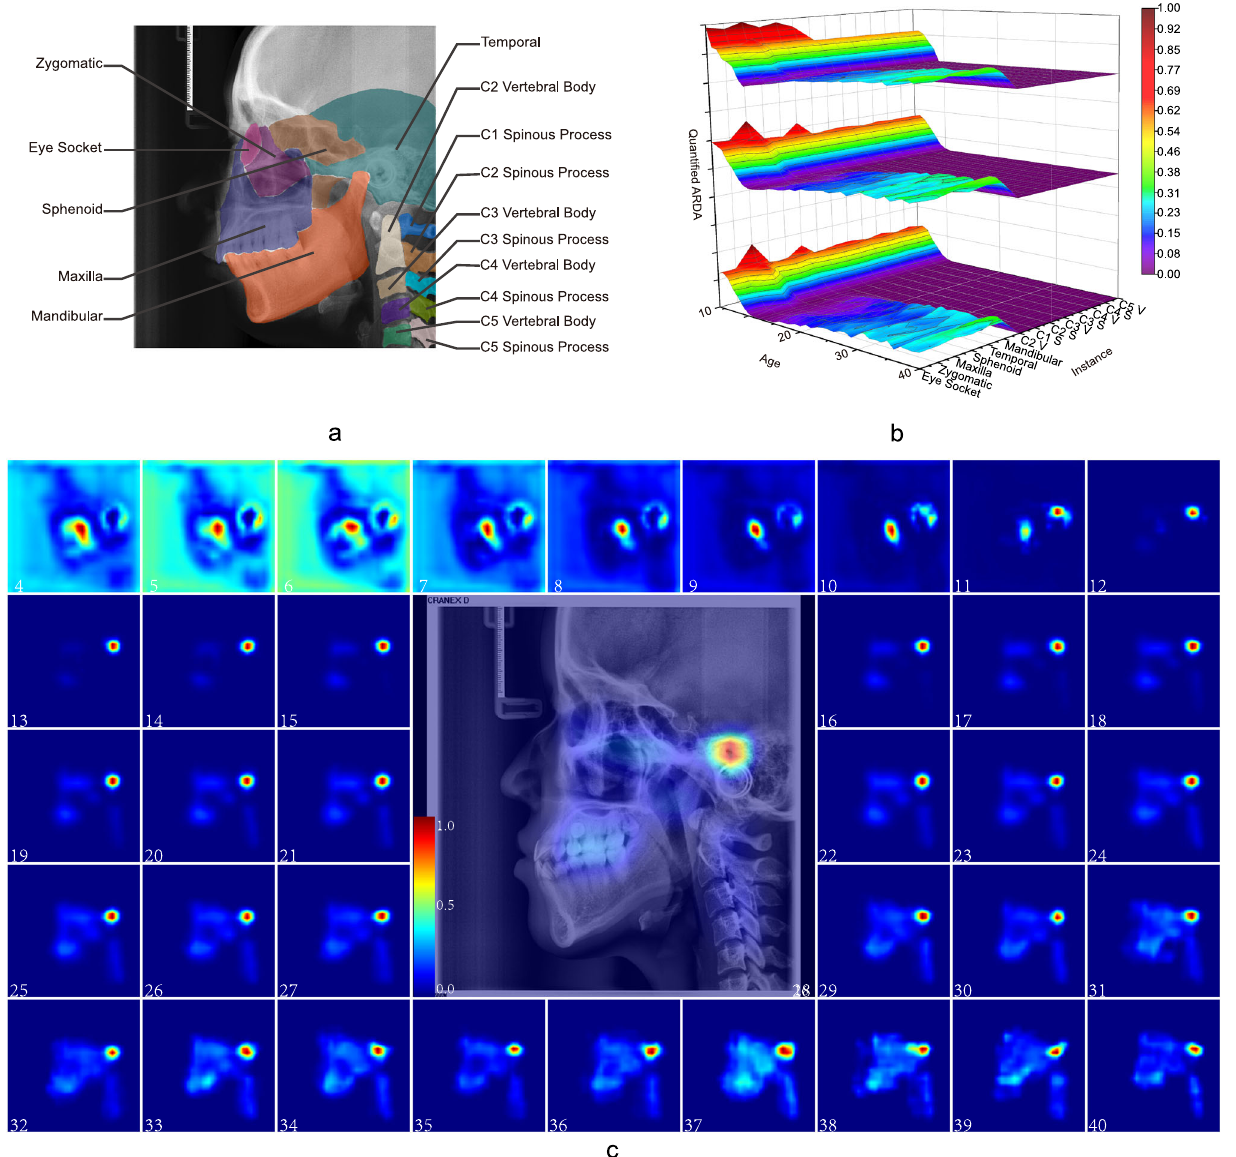
Fig. 1 The ARDA of LCR images. The ARDA is generated from LCR images and a pre-trained deep learning ageing feature extractor. a Instances in LCR images. The parietal and frontal instances are not labeled because the ARDA is barely distributed on them. b Illustration of the quantitative distribution of ARDA on instances in LCR images. The three dimensions are age, instance and quanti fi ed ARDA. The contours and position of each instance are shown in a . The quanti fi ed ARDA of each instance is the mean value of the average ageing salience of the ageing-signi fi cant regions it contains. From the bottom to the top are the cases in which the threshold of ageing-signi fi cant region is set to the median, 75-th percentile, and 90-th percentile of corresponding ARDA, respectively. In the dimension of instances, Cx V and Cx S represent the x-th vertebral body and the x-th spinous processes of the cervical spine, respectively. c The ARDA map of LCR images. To visualize the distribution of ARDA and ageing regions, we mapped the average ageing salience to a color ranging from blue to red. The closer the color of the pixel in the ARDA map is to red, the larger the average ageing salience of the pixel. We display the LCR image of a randomly selected 28- year-old subject overlaid with its corresponding ageing salience map to show the relative position between the ARDA map and the LCR image. Source data are provided as a Source Data fi